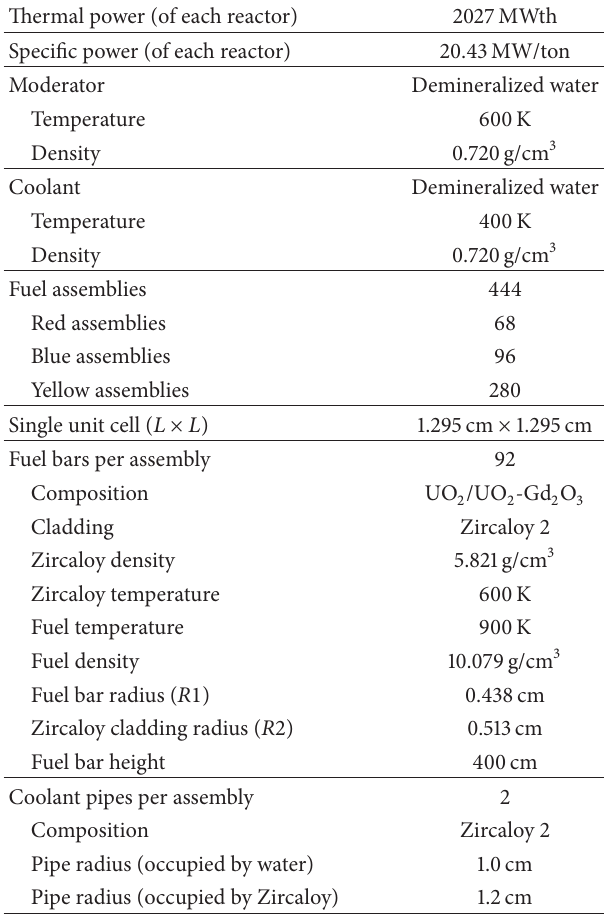
Table 3: Parameters of the BWR core used in the simulation with DRAGON code